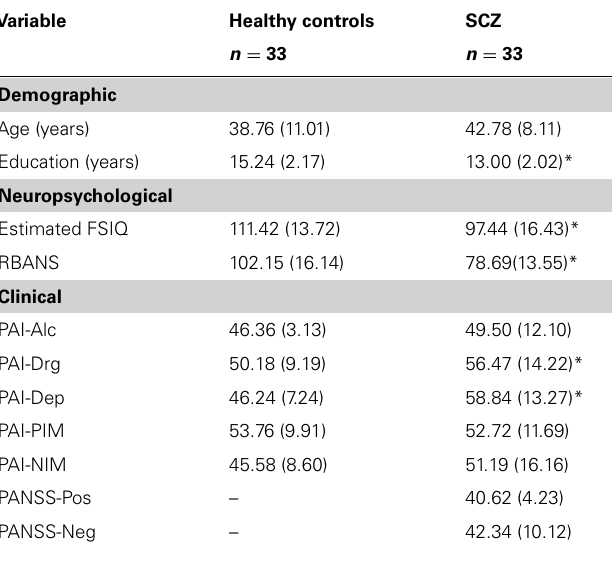
Table 1 | Means (SD) for demographic, neuropsychological, and clinical characteristics of the sample.